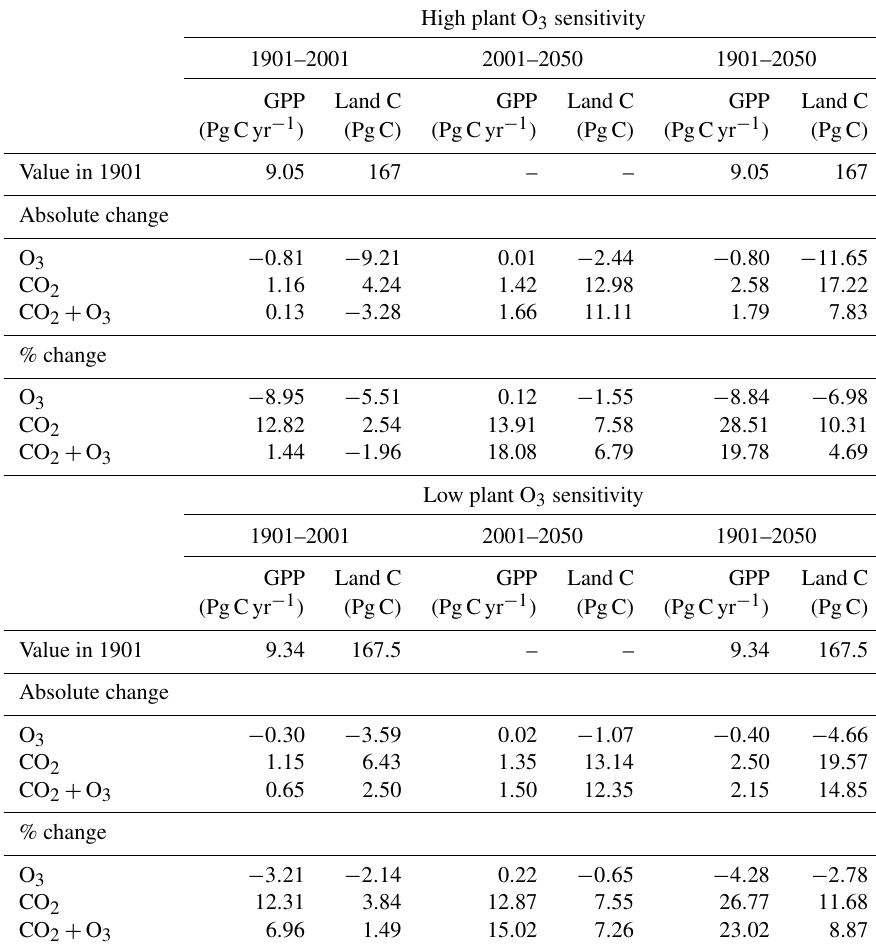
Table 1. Simulated changes in the European land carbon cycle due to changing O 3 and CO 2 concentrations (independently and together). Shown are changes in total carbon stocks (Land C) and gross primary productivity (GPP) over three different periods (historical: 1901 to 2001; future: 2001 to 2050; and full time series: 1901 to 2050). Absolute (top) and relative (bottom) differences are shown. For 2001 to 2050, please refer to Table S4 for the initial value for each run. See the Supplement for details of the estimation of the O 3 and CO 2 effects and their